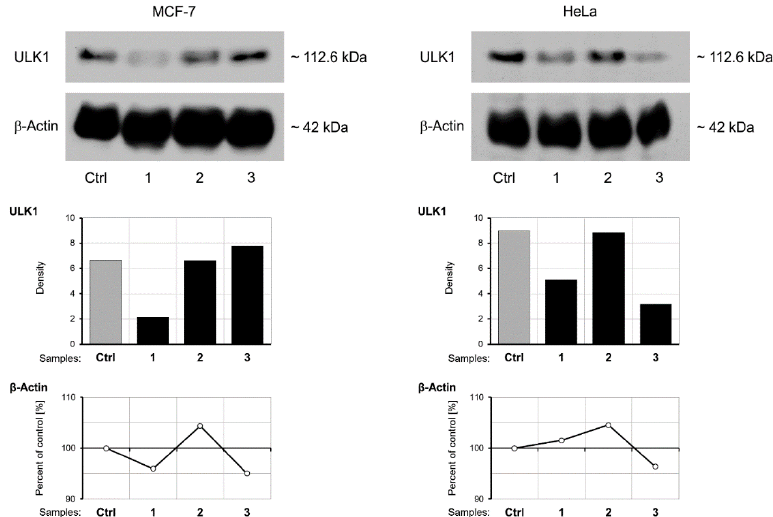
Figure 8. Western Blotting analysis of ULK-1 expression as a marker of autophagy in MCF-7 and HeLa cells after 48 h of treatment with IC 50 concentrations of DE and SWE extracts and resveratrol. Ctrl — control; 1 — dry extract; 2 — subcritical water extract; 3 — resveratrol.